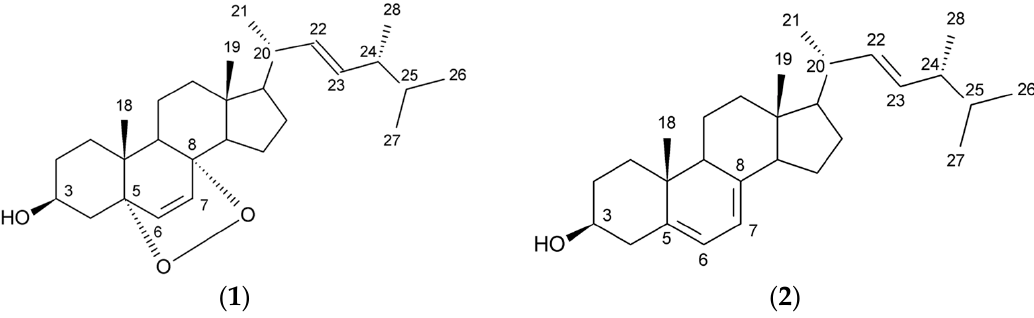
Figure 1. Chemical structures of the isolated compounds: ergosterol peroxide ( 1 ); ergosterol ( 2 ).